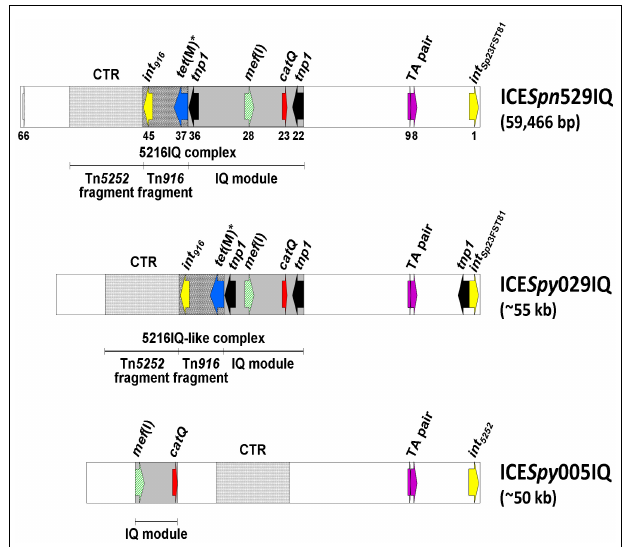
FIGURE 2 | Schematic representation of ICE Spn 529IQ, completely sequenced, and of ICE Spy 029IQ and ICE Spy 005IQ, characterized by PCR mapping, partial DNA sequencing and restriction analysis. The ICE genomes are represented as white rectangles with some ORFs and some modules or fragments in evidence.The IQ module is depicted as a gray rectangle, theTn 916 fragment as a spotted rectangle, and the CTR module as a dotted rectangle.The ORFs are depicted as arrows pointing in the direction of transcription, including mef (I) (diagonally striped green), catQ (red), tnp1 (black), integrase genes (yellow),TA gene pair (purple), and silent tet (M) (blue). orf66 of ICE Spn 529IQ is white.The progressive number is reported only below selected ones of the 66 ORFs of ICE Spn